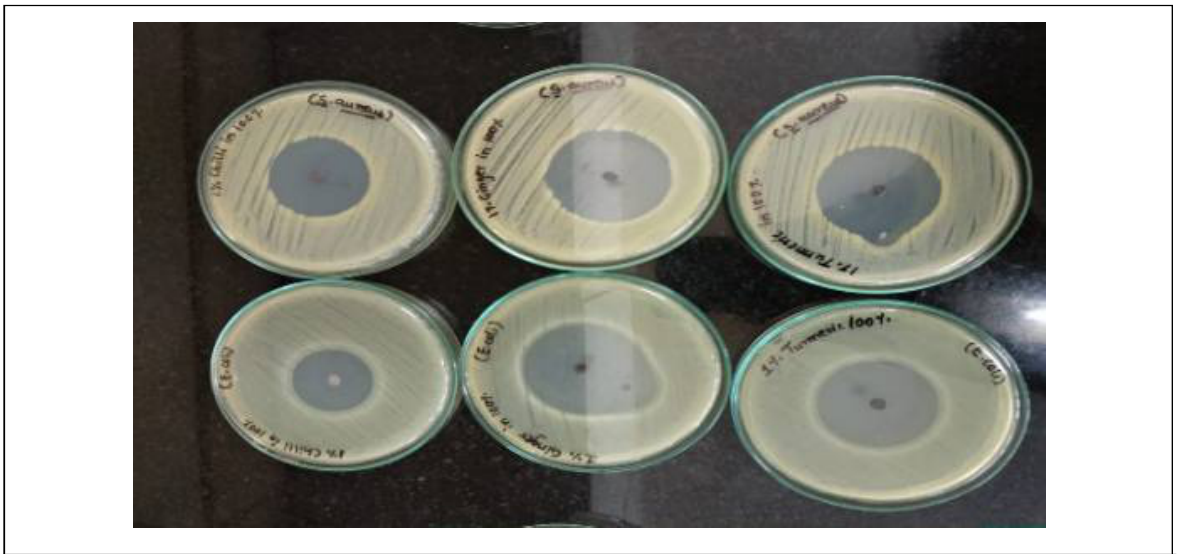
Figure 2: Zones of inhibition exhibited by 1% spice extracts prepared in 100% of